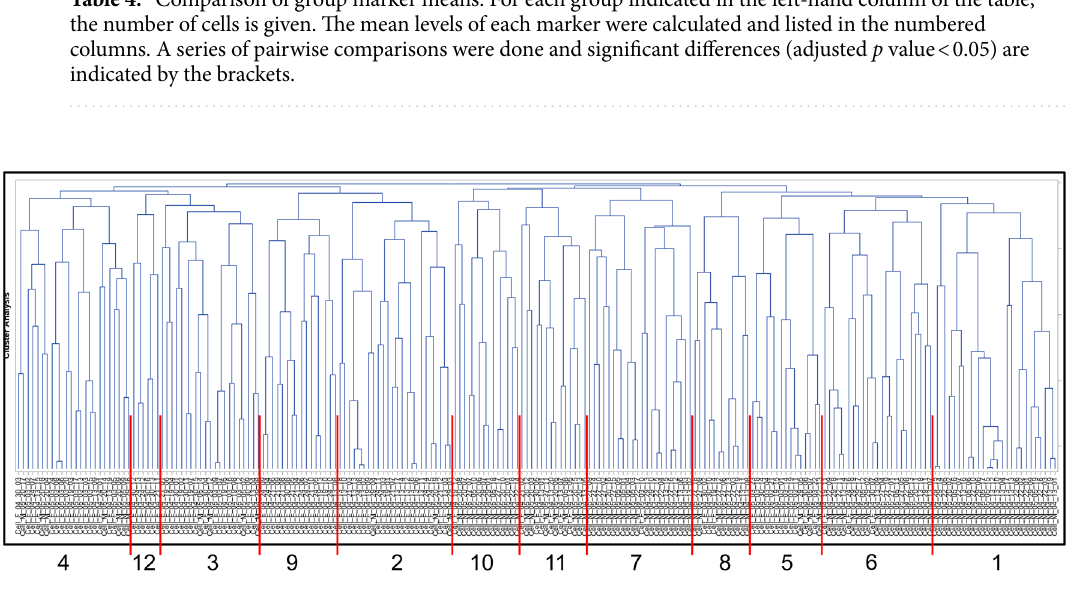
Figure 6. Dendrogram of sex comparison. A clustering analysis of the combined female/male data with the 7 markers in common in both studies (see Table 1) was done using SAS, Version 9.4 and the resulting 12-cluster dendrogram is shown. Cluster numbers are assigned by the statistical